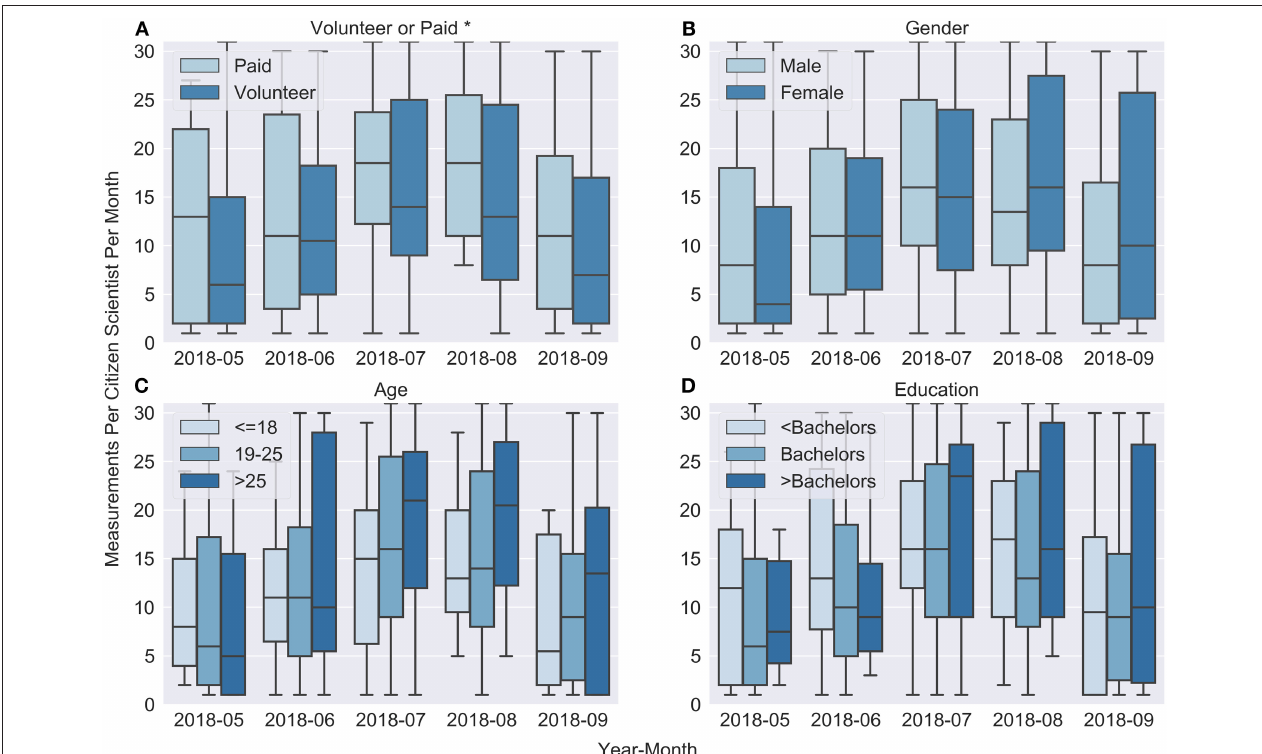
FIGURE 7 | Grouped box plots showing the medians and distributions of the number of citizen scientist precipitation observations per month. Box plot groups are shown for four different categories: (A) volunteer or paid; (B) gender, (C) age, and (D) education. For education, citizen scientists were classified into the highest education level that they had either completed or were currently enrolled in. An asterisk (*) in the subplot title indicates statistically significant differences (alpha level = 0.01) between the number of measurements performed by each group within that category during the entire 5-month period.